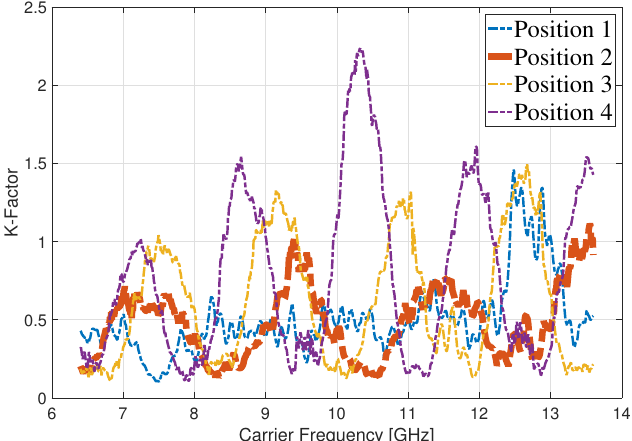
Figure 7. The K-Factor versus carrier frequency observed at 4 user